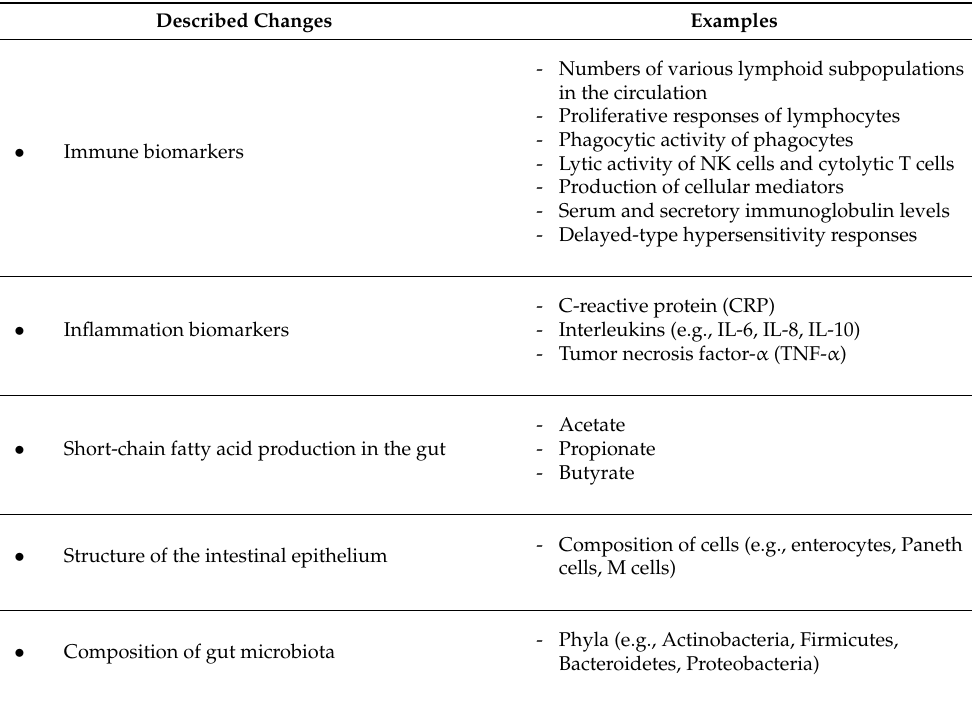
Table 1. Changes in biomarkers that are proposed as outcomes for substantiating health claims related to immune function